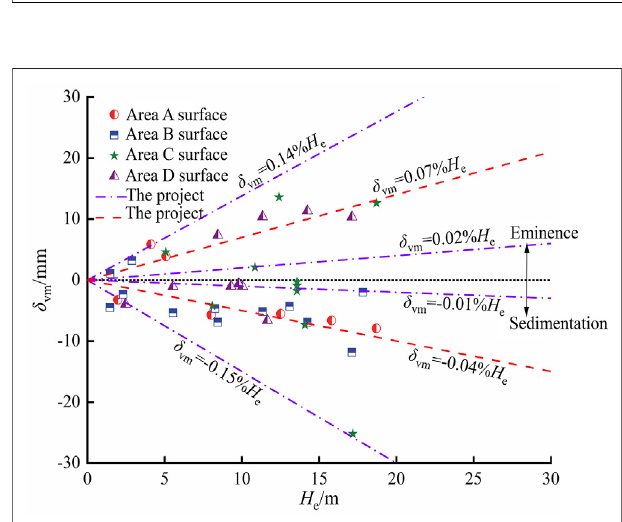
FIGURE6| V qd underdifferentworkingconditionsand relationshipsbetween V qd and H e . (A) V qd underdifferentworkingconditions. (B) Relationshipbetween V qd and H e .